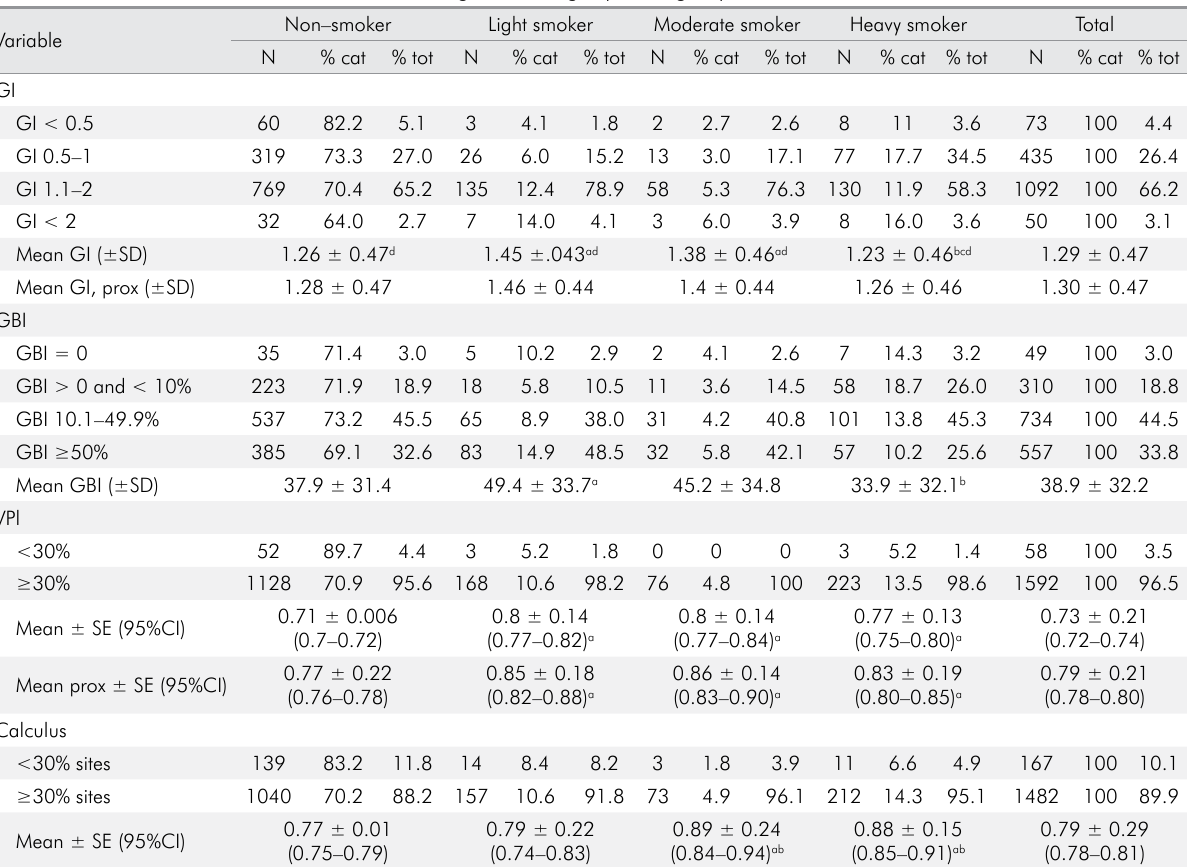
Table 2. Distribution of clinical variables according to smoking exposure group.